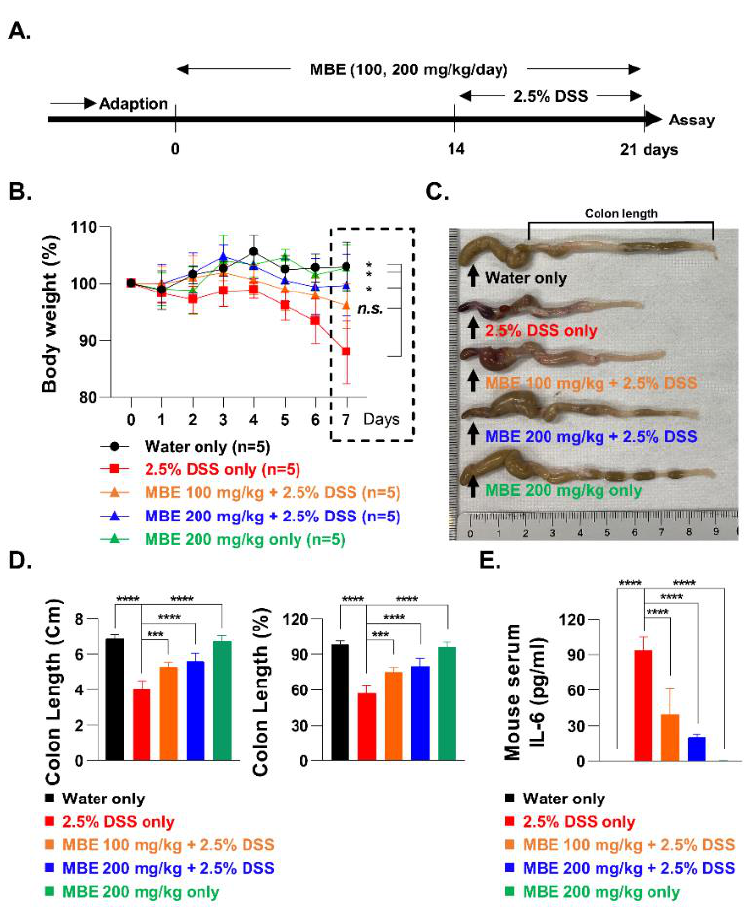
Figure 1. MBE treatment alleviates DSS-induced colitis. ( A ) Schematic representation of MBE oral administration to mice. ( B ) The weights of mice were recorded daily for the last 7 days of treatment. ( C ) Representative images of the colon length from each group. ( D ) All colon lengths were measured from the ileocecal junction to the distal end of the rectum. ( E ) IL-6 levels in mouse serum were measured using ELISA. n = 5 for each group. * p <0.05, ** p < 0.01, *** p < 0.001, and **** p <0.0001 (data were analyzed using an ANOVA); ns, not